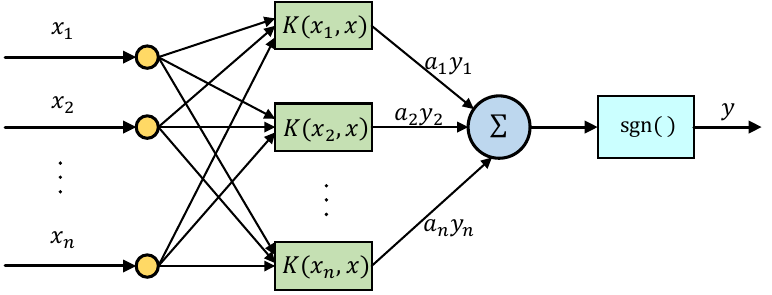
Figure 2. Schematic diagram of SVM structure.